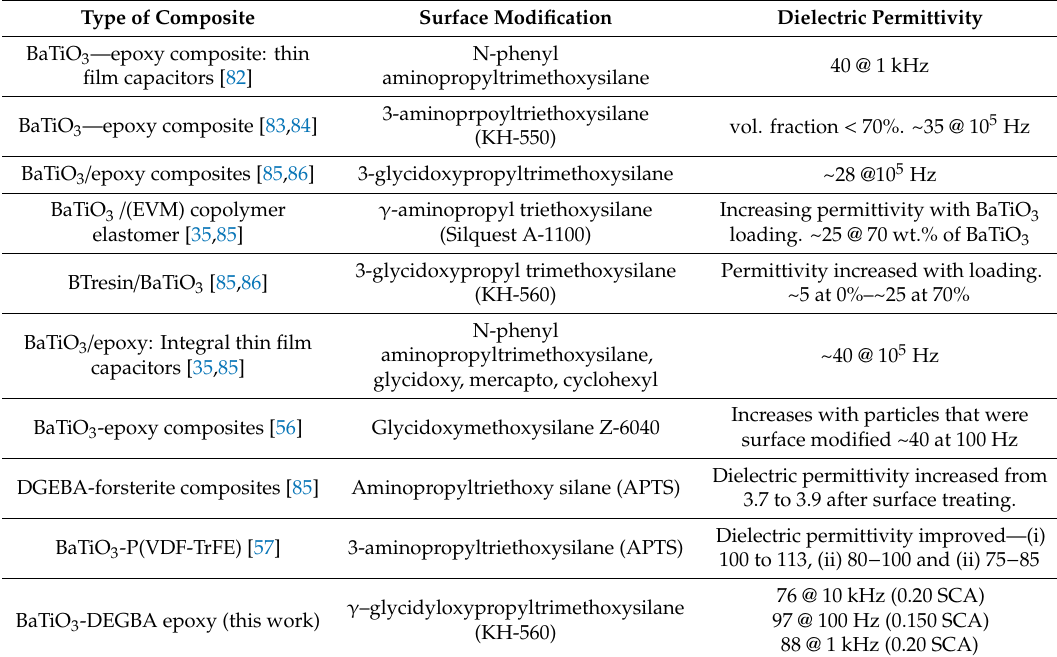
Table 4. Comparison of this work effort with other notable researchers who have fabricated state of the art materials.